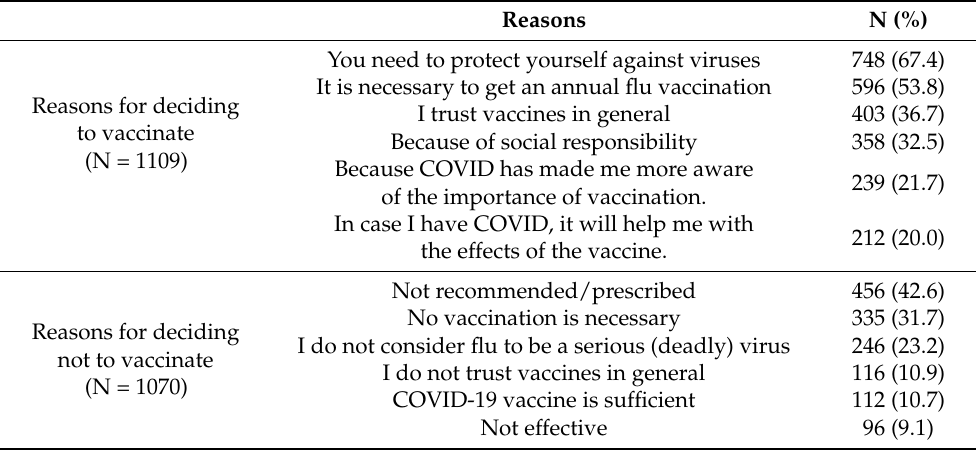
Table 5. Reasons why people expressed that they were hesitant to get vaccinated against flu or not in the 2021/2022 campaign 1 .